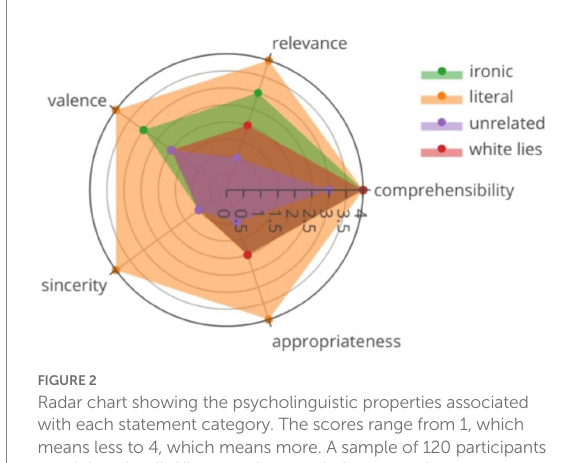
FIGURE 2 Radar chart showing the psycholinguistic properties associated with each statement category. The scores range from 1, which means less to 4, which means more. A sample of 120 participants rated the stimuli. All categories met their expected psycholinguistic properties. See text for additional